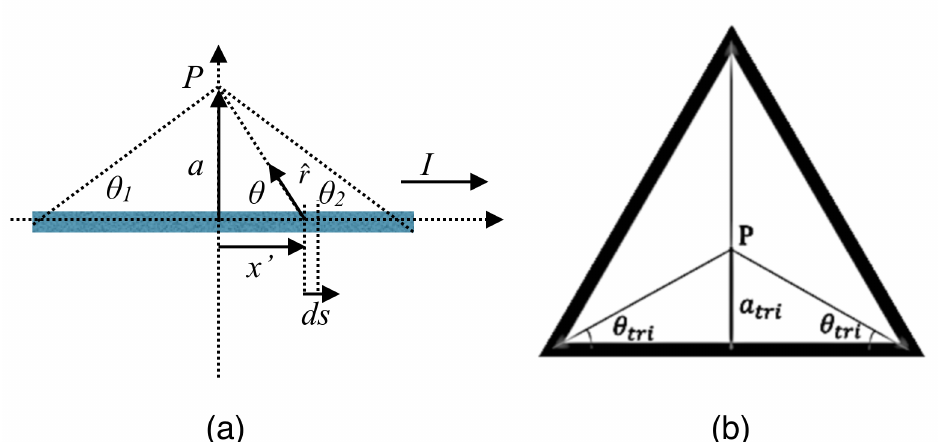
Figure 5. ( a ) Magnetic field of a piece of straight wire at an arbitrary point P and ( b ) triangular cross-section profile